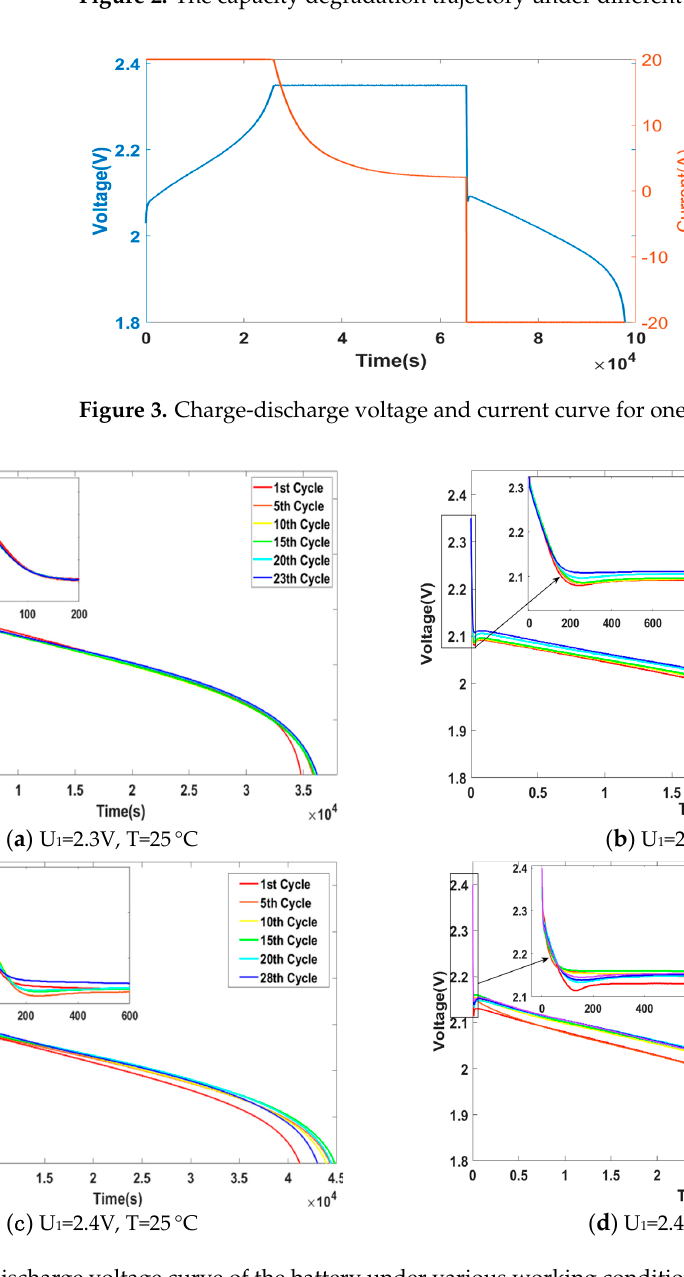
Figure 4. The discharge voltage curve of the battery under various working conditions and different cycle